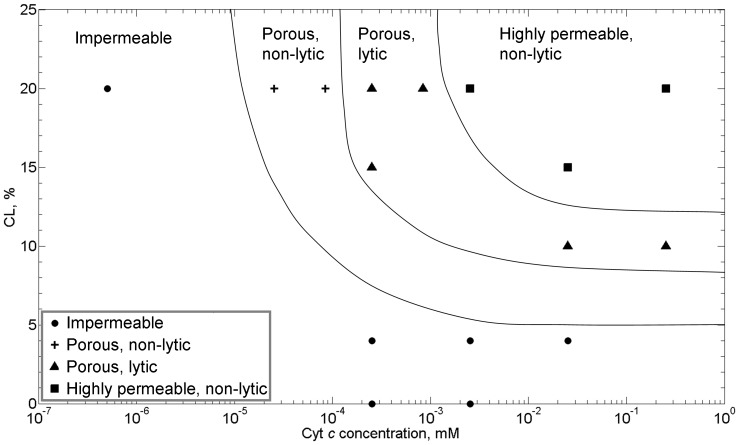
Permeability “map” of the system as a function of cyt c concentration in solution and cardiolpin concentration in the membrane.Different states of permealization are delineated: • impermeable;+porous, non-lytic; ▴ porous, lytic; ▪ highly permeable, non-lytic. Lines are guides to eye delineating the various states. Buffer: 200 mM KCl, 10 mM MOPS, pH 7.4; voltage clamp: −50 mV. All the lipid membranes contain 25% chol, except that the 0% CL lipid membrane doesn’t contain any chol. Each data point in the permeability “map” is deduced from a miniumum of 5 independent experiments.